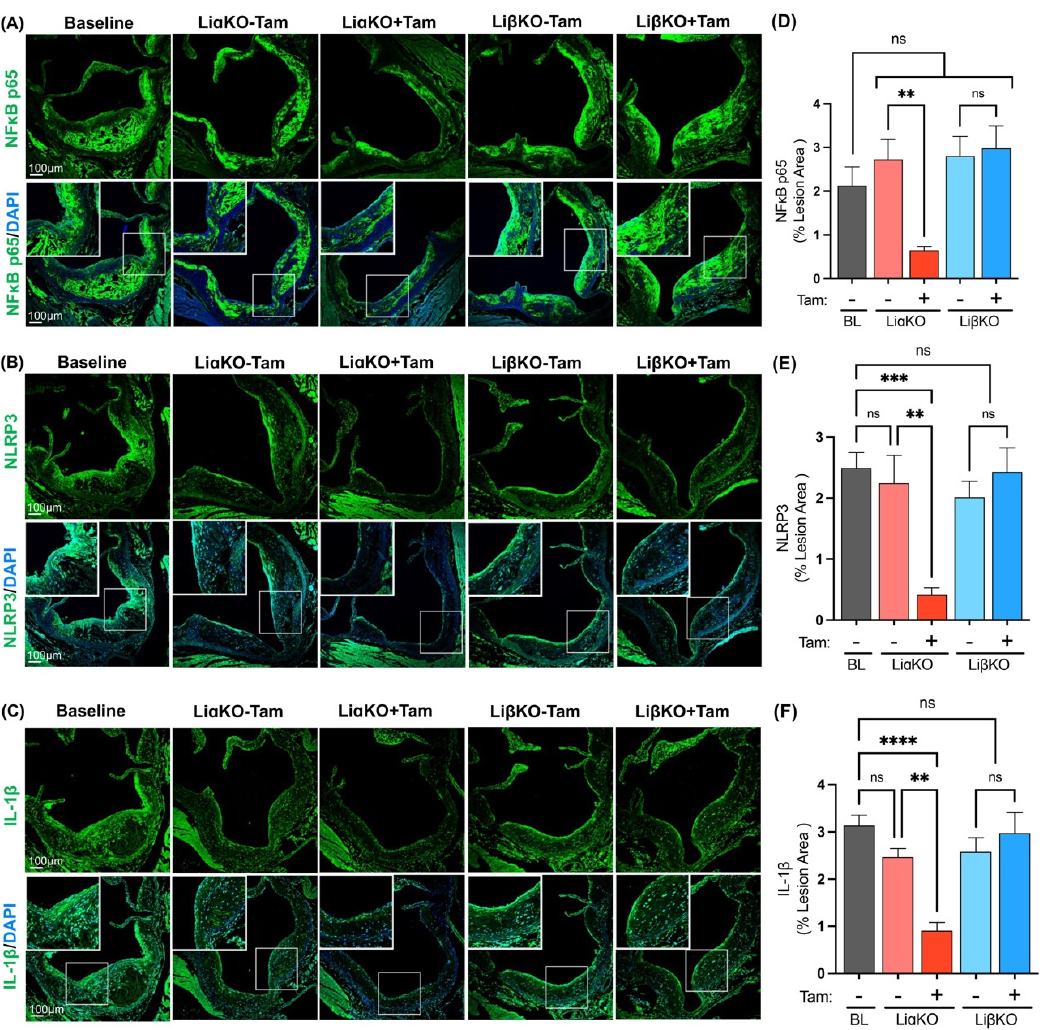
Figure 4. Reduced pro-inflammatory response in female GSK3 α -deficient Ldlr − / − mice. Representative sections of aortic sinus immunostained with an antibody against ( A ) NF κ B (green), ( B ) NLRP3 (green), or ( C ) IL-1 β (green). Quantification of ( D ) NF κ B p65 and ( E ) NLRP3 and ( F ) IL-1 β stained area normalized to the total lesion area. n = 9–13; mean ± SEM; ** p < 0.01, *** p < 0.001, **** p < 0.0001 (one-way ANOVA). ns, not significant; Tam, tamoxifen; BL, baseline; NF κ B, nuclear factor kappa-light-chain-enhancer of activated B cells; NLRP3, NLR family pyrin domain containing 3; IL-1 β , interleukin-1 β .